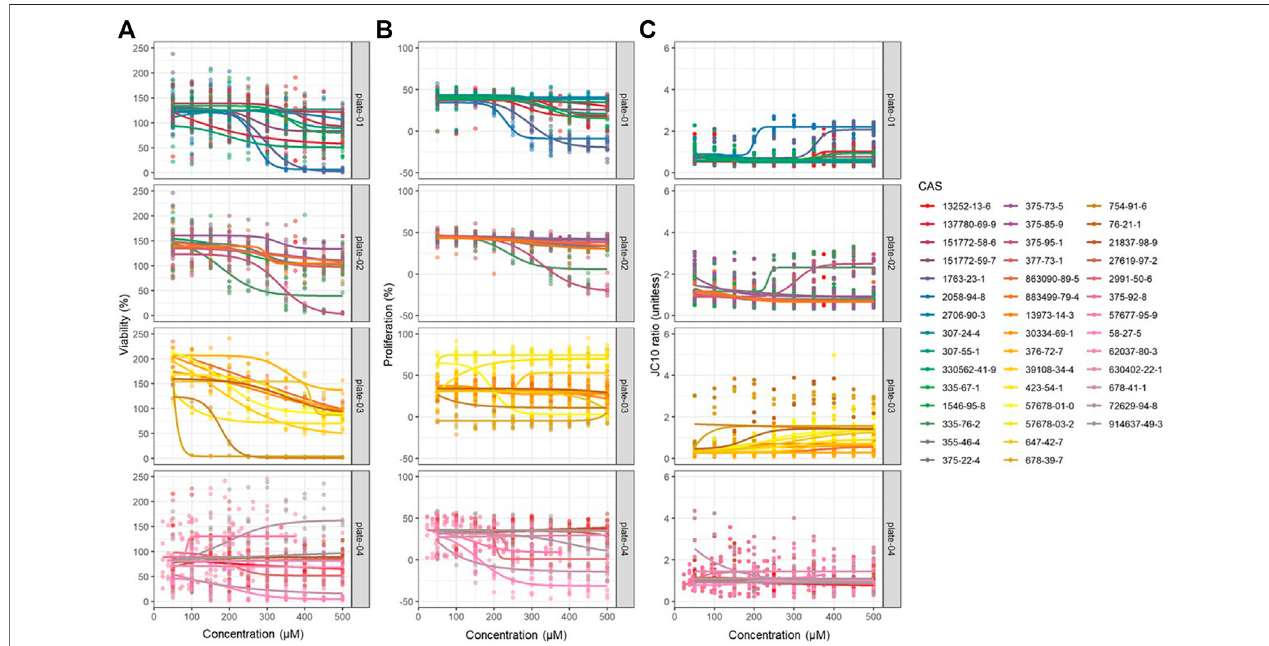
FIGURE 1 | Dose-response modeling results obtained from JEG-3 cells exposed to 42 different PFAS congeners for 24 h corresponding to (A) viability, (B) proliferation, and (C) mitochondrial membrane potential (MMP). Data were fi t to a four-parameter dose-response model with no constraints and EC50 estimates were extracted. N = 3 biological